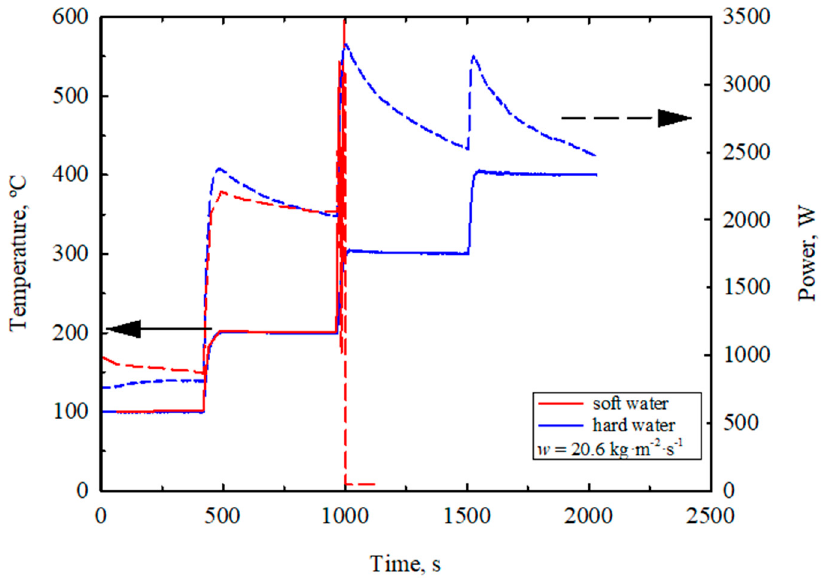
Figure 4. Measured sample temperature and consumed electric power during stepwise T rising using hard and soft water-air mists with water impingement density equal to 20.6 kg·m − 2 ·s − 1 delivered by a nozzle CasterJet 6.5-90.